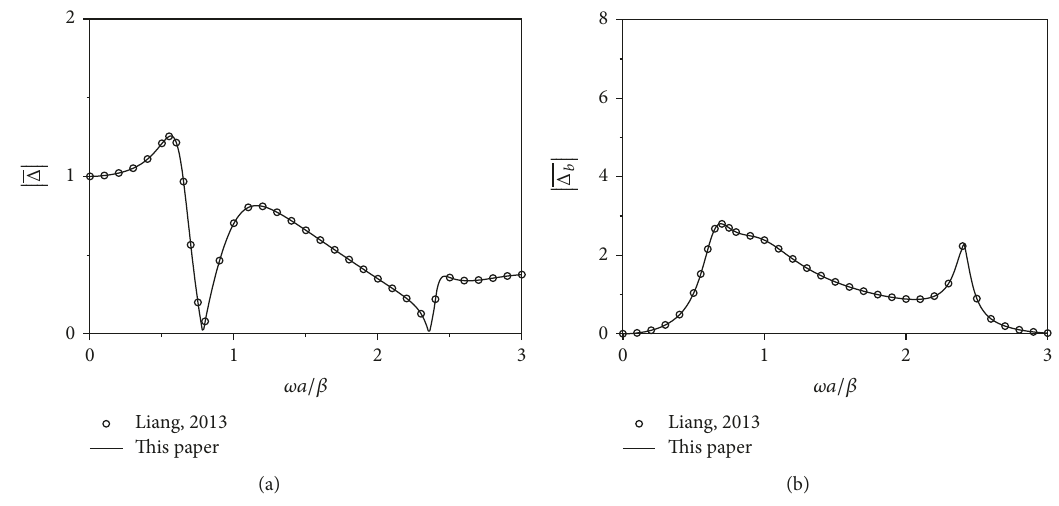
Figure 2: Comparison between study results and literature results [23].